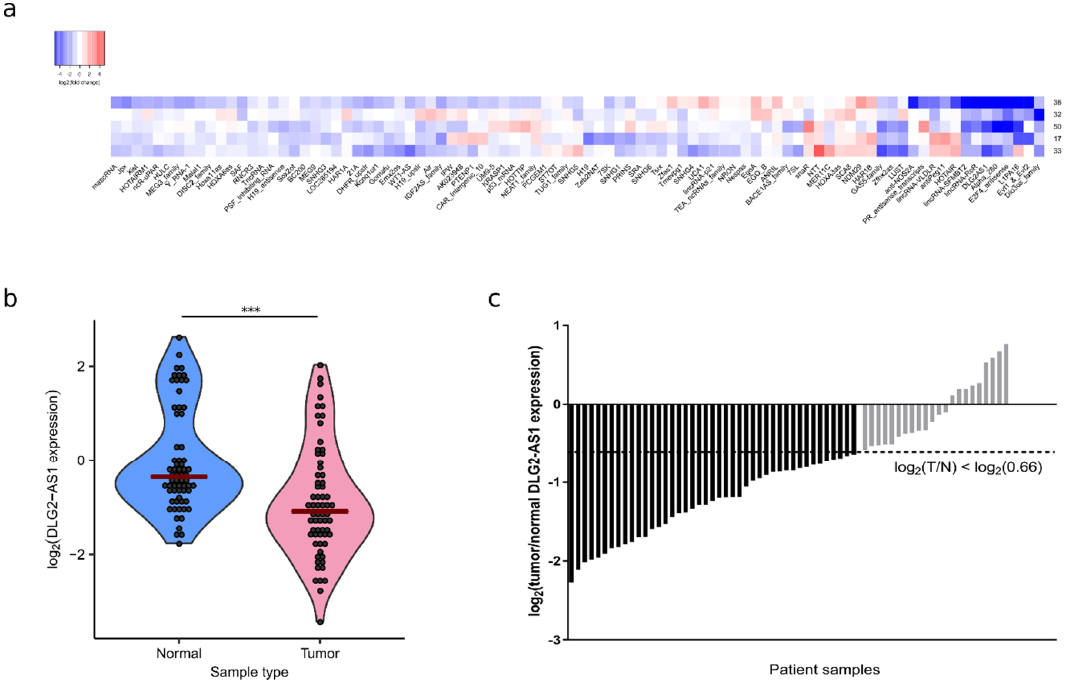
Figure 1. LncRNA DLG2-AS1 is downregulated in lung adenocarcinoma (LUAD). ( a ) heatmap of the 90 lncRNAs analyzed with the Human LncRNA Profile Kit from System Biosciences (SBI); ( b ) DLG2-AS1 expression in normal and tumor samples; and ( c ) tumor / normal fold change (FC(T / N)) of DLG2-AS1 expression in the 65 LUAD patients. Shown in a darker color are the patients who presented DLG2-AS1 downregulation (FC(T / N) < 0.66). *** = p -value < 0.001.